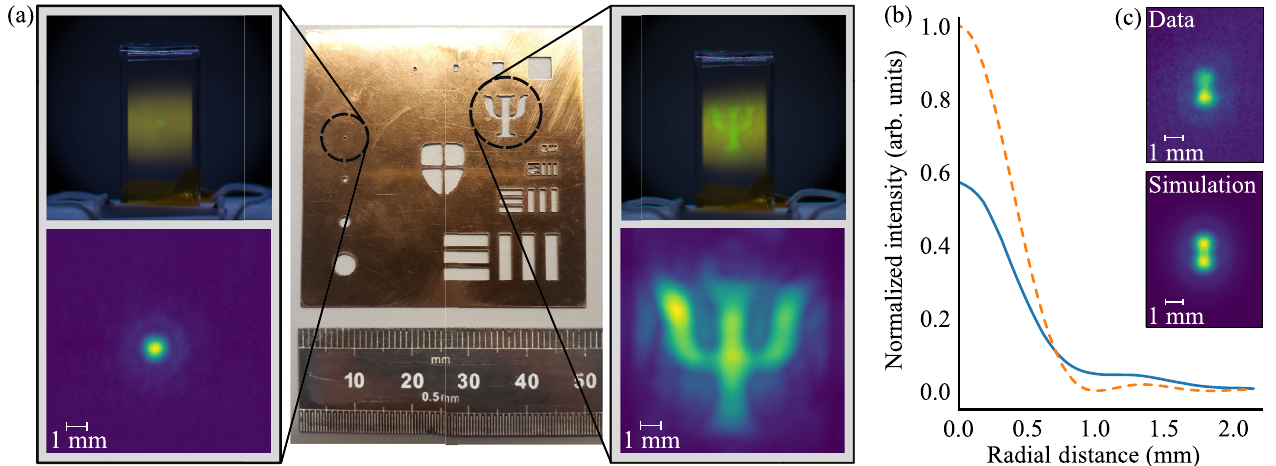
FIG. 2. Demonstration of spatial resolution. (a) A metal mask (center) placed in the object plane of the system. To the left and right are true-color images taken with camera A (above) and false-color images taken with camera B (below) for a 0.50-mm-diameter pinhole (left) and a “ Ψ ” -shaped aperture (right). (b) Radially averaged intensity profiles of the measured PSF (solid blue line) and the simulated ideal PSF (dashed orange line). Both PSFs were scaled such that the total power in each image was equal. The ratio of peak heights gives a Strehl ratio of 0.57. (c) Real (top panel) and simulated (bottom panel) images of two 0.50-mm-diameter pinholes separated by 1.00 mm.